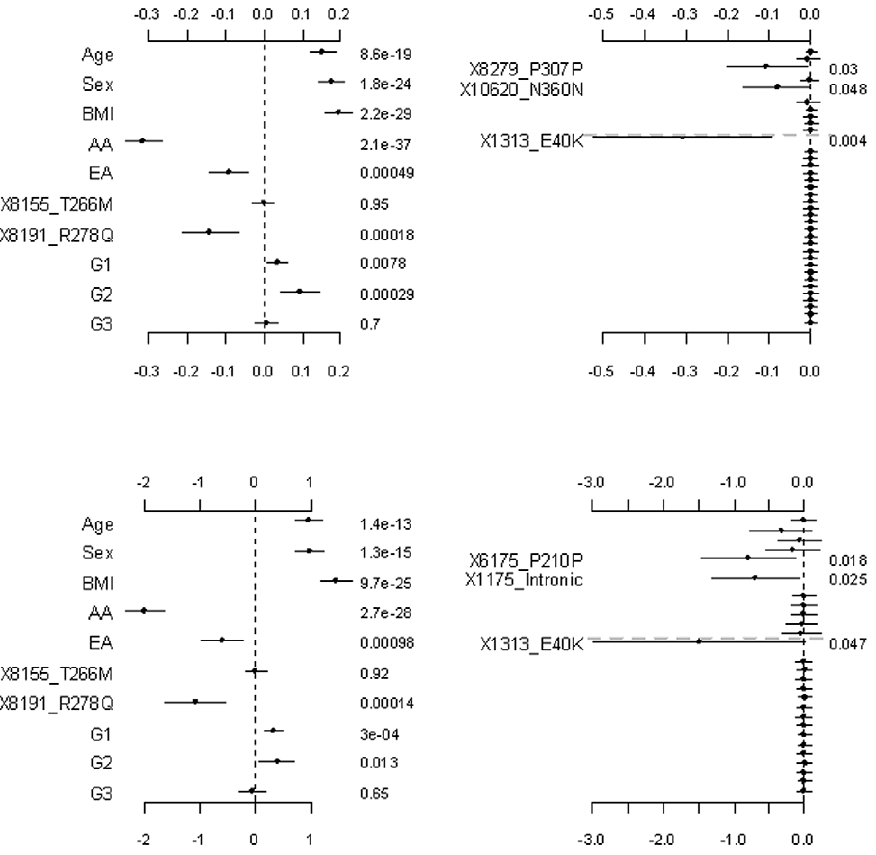
Figure 2. Analyses of the proposed hierarchical GLMs with prior means m j =1 for all variants. The top and bottom panels are for the continuous and binary traits, respectively. The left panel is for the covariates, the two common non-synonymous variants and the three group effects (G1: common synonymous; G2: rare non-synonymous; G3: rare synonymous). The right panel is for the adjusted main effects (the gray dotted line shows the two groups G1 and G2). The points, short lines and numbers at the right side represent estimates of effects, 6 2 standard errors, and p - values, respectively. Only adjusted main effects with p -value , 0.1 are labeled.